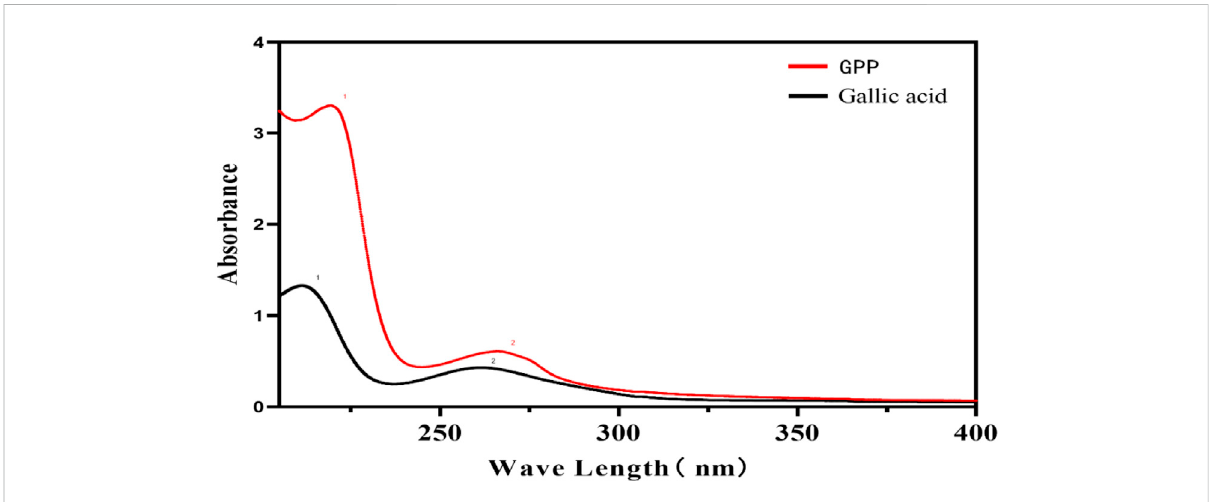
FIGURE 2 UV spectra of GPP and Gallic acid reference